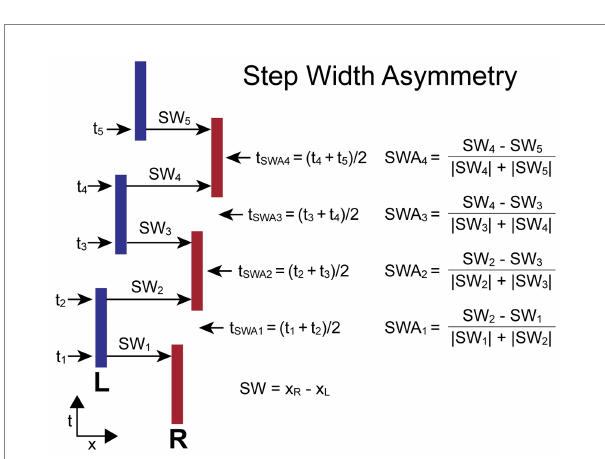
FIGURE 2 Step Width Asymmetry ( SWA ) calculation parameters and